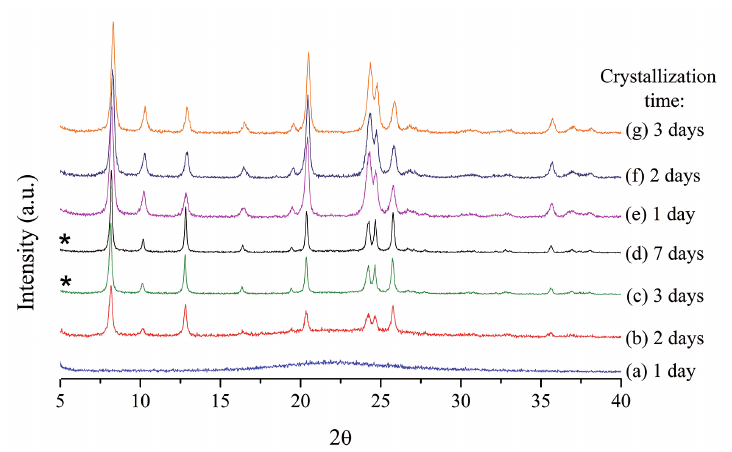
Figure 3: X-ray diffractograms of zeolites obtained by method A (using ionic liquid as OSDA) with reaction times of (a) 1 day, (b) 2 days, (c) 3 days, (d) 7 days in static mode, and (e) 1 day, (f) 2 days, (g) 3 days with stirring.